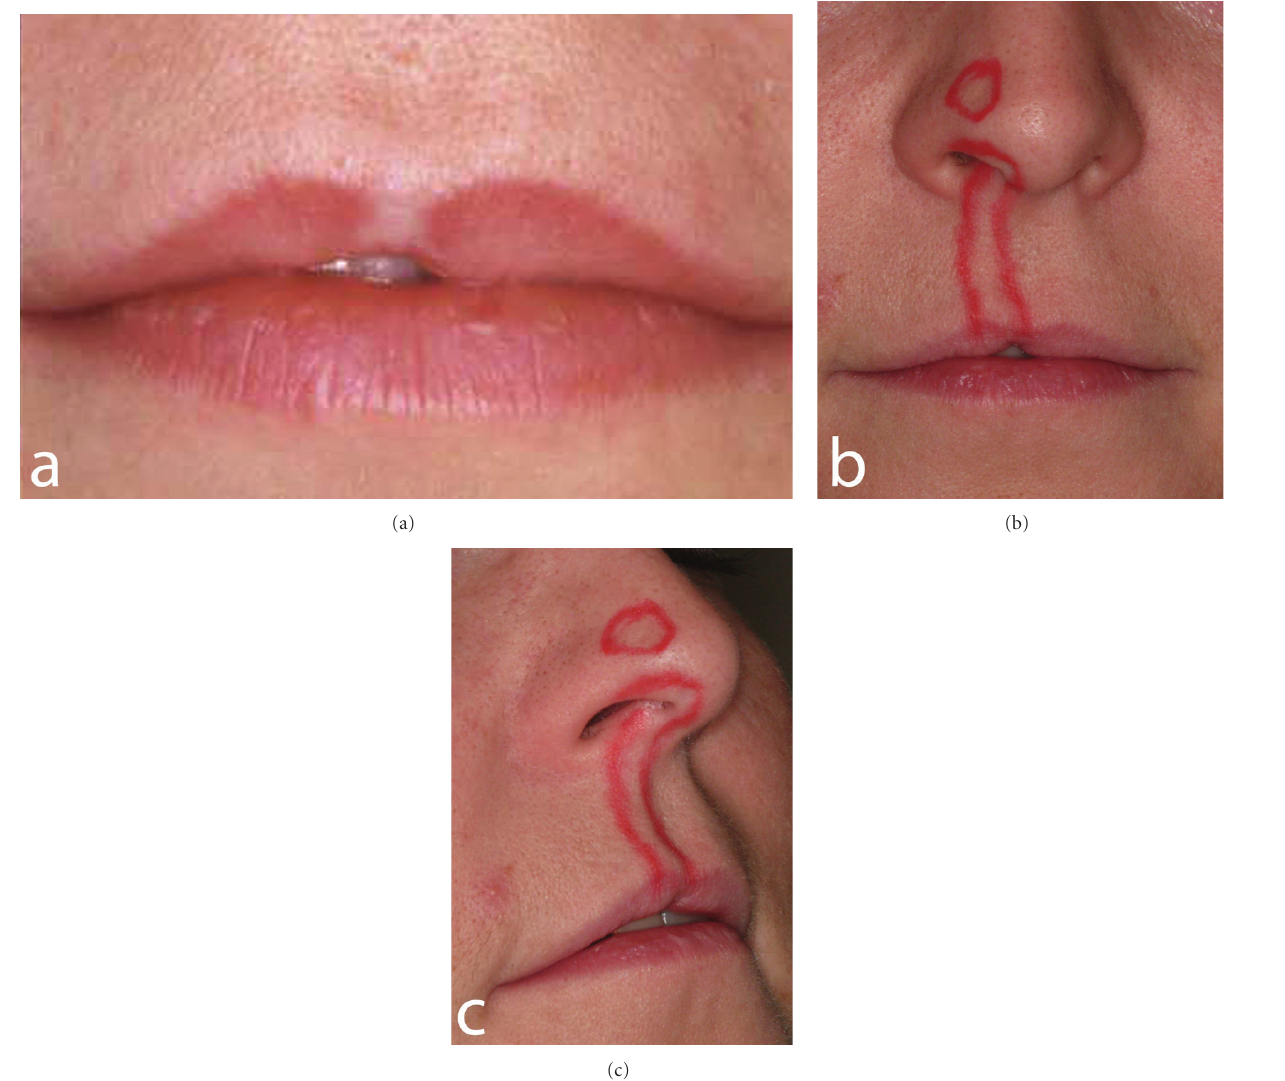
Figure 5: Patient 1: extraoral photographs. (a) The photograph shows retraction of the lip in the area of the central incisor. A white fibrous area is seen in the otherwise red prolabium in the same area. (b) and (c) Red colour marks the area of the skin at the upper lip and nose where the sensitivity is di ff erent (feeling of dead